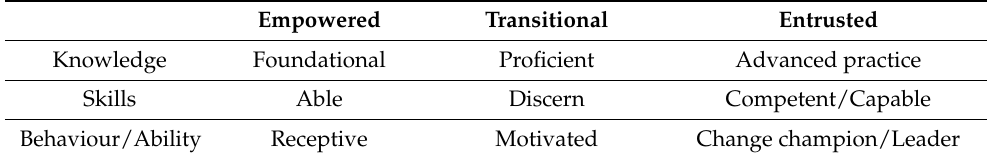
Figure 5. Visual representation of COMPASS theoretical framework and implementation model. Table 2. COMPASS Capability continuum.